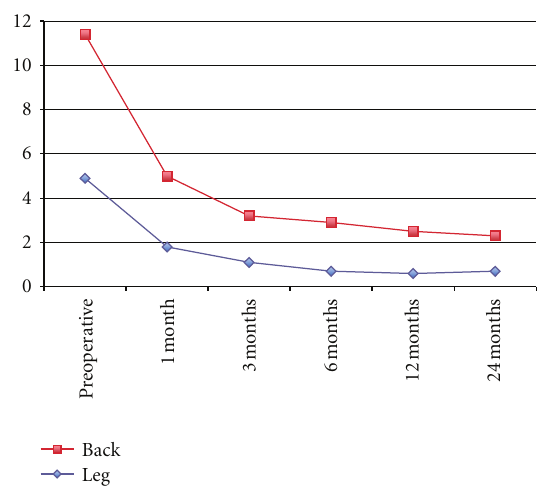
Figure 4: Oswestry Disability Index at baseline and 1, 3, 6, 12, and 24 months after operation.